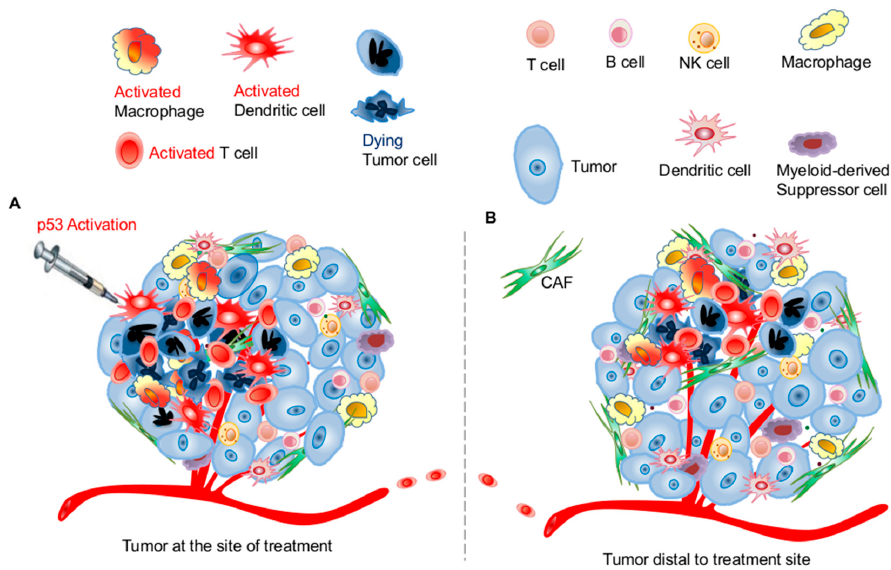
Figure 2. Targeting the p53 pathway in the tumor microenvironment (TME) to activate antitumor immunity for systemic tumor control. Local activation of the p53 pathway in the TME can be achieved